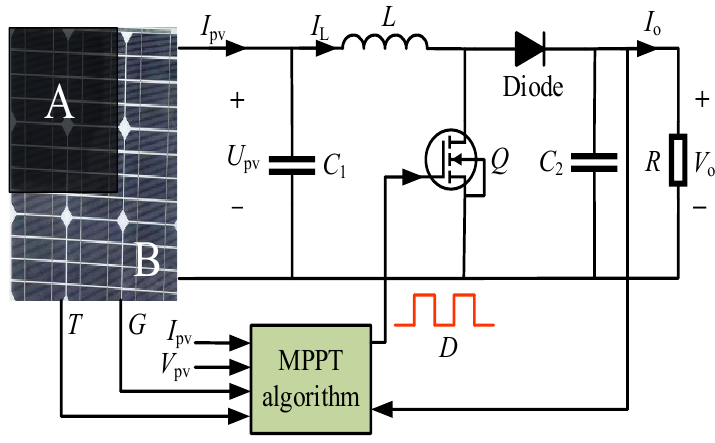
Figure 7. Topology of PV boost converter.